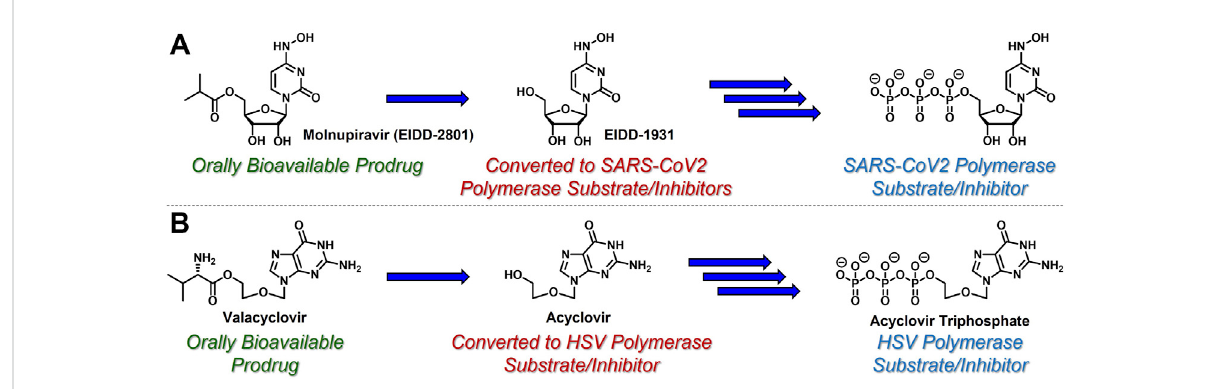
FIGURE 2 Nucleoside-based antiviral therapeutics (A) molnupiravir (EIDD-2801) and (B) valacyclovir are orally bioavailable prodrugs that release cyclic nucleoside EIDD-1931 and acyclic nucleoside acyclovir, respectively, both of which are then converted to the corresponding, viral polymerase- inhibiting